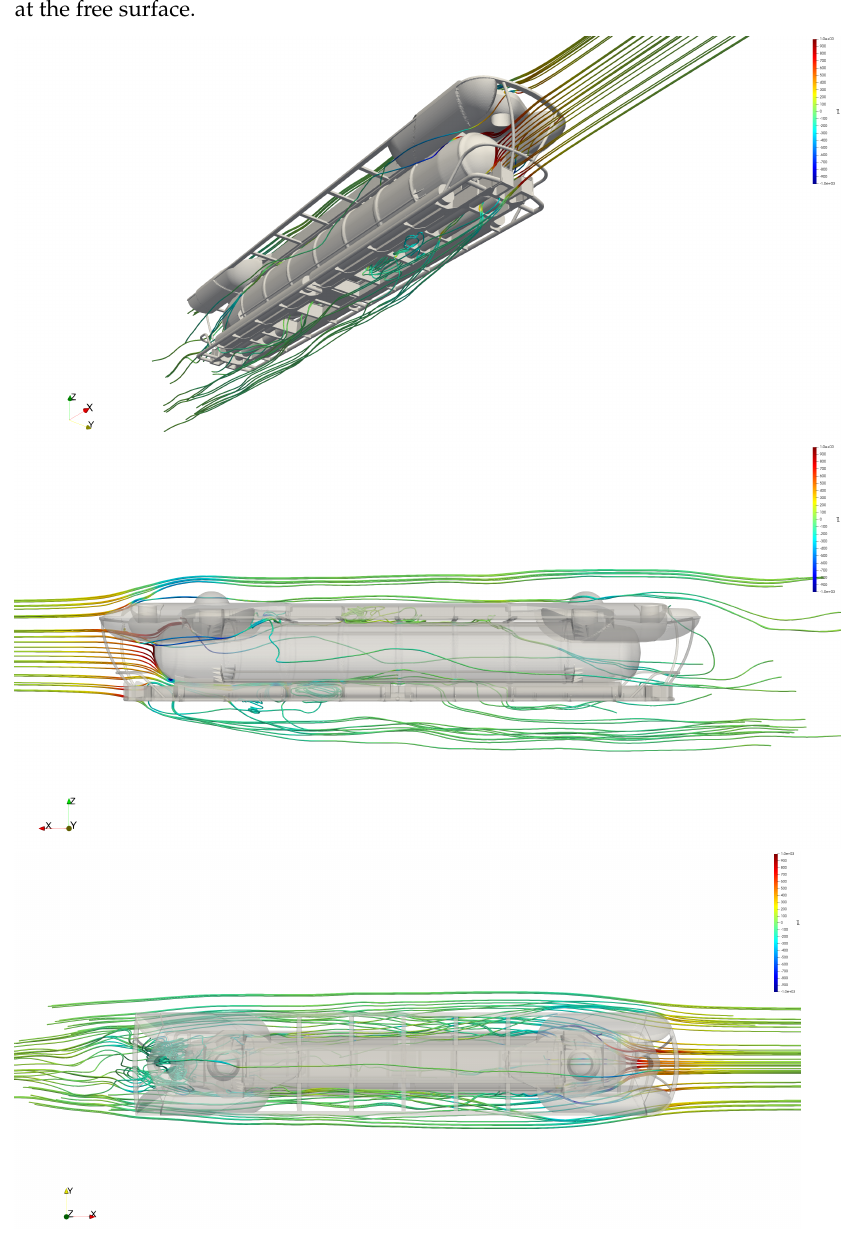
Figure 15. Streamlines around the submarine when sailing at 3 knots speed at 40 m